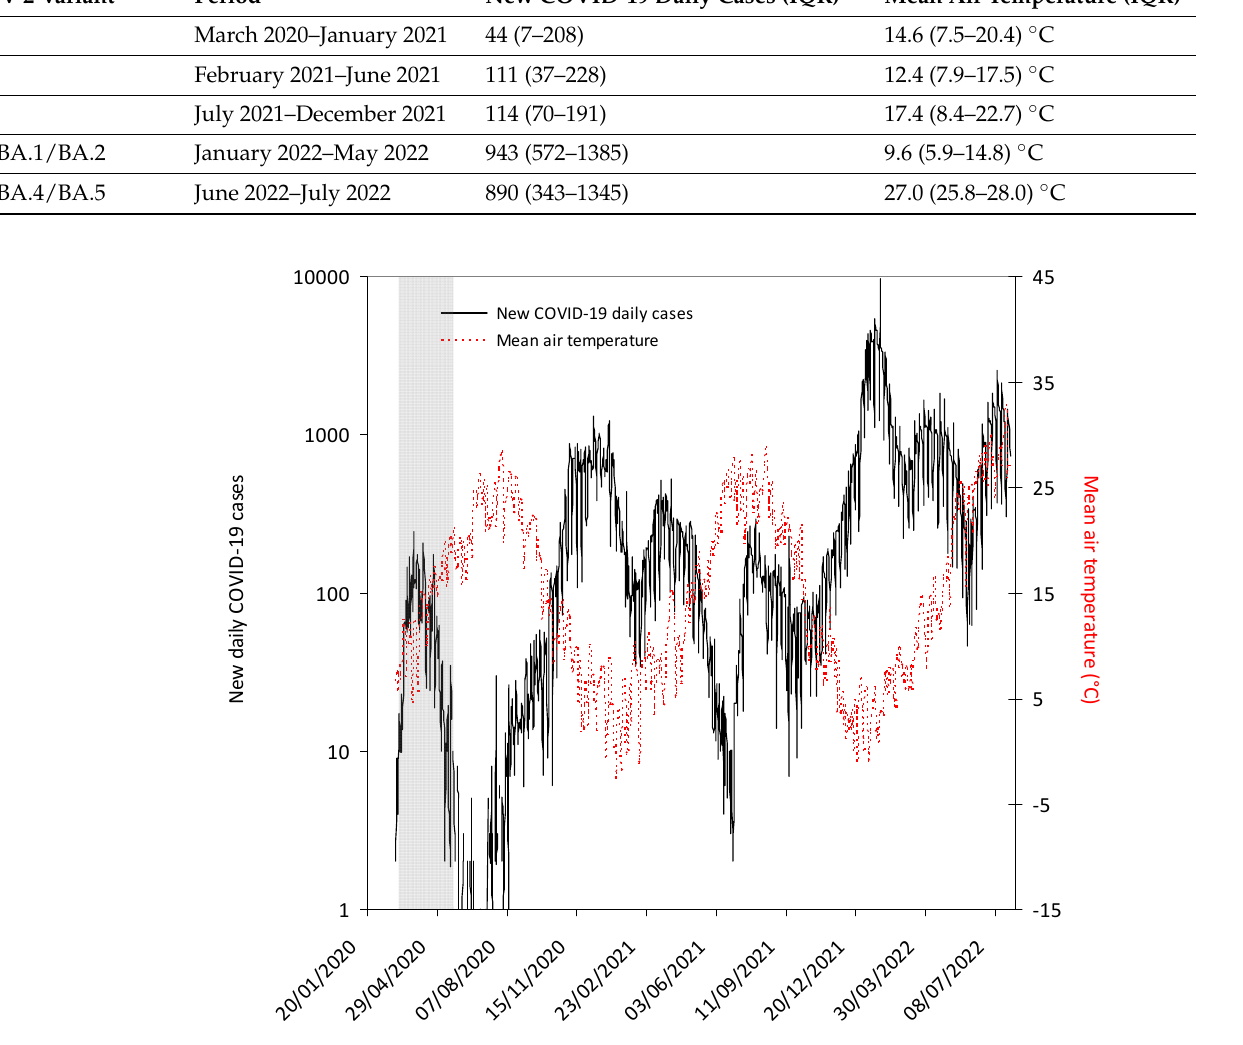
Figure 1. The number of new coronavirus disease 2019 (COVID-19) daily cases recorded in the province of Verona and fluctuation of mean air temperature in the same area throughout the study period. The grey area indicates the lockdown period in Italy (9 March 2020–18 May 2020). The mandatory requirement to wear face mask in open spaces and within closed areas (except healthcare facilities) was definitively abrogated from 11 February 2022 and 15 June 2022, respectively.